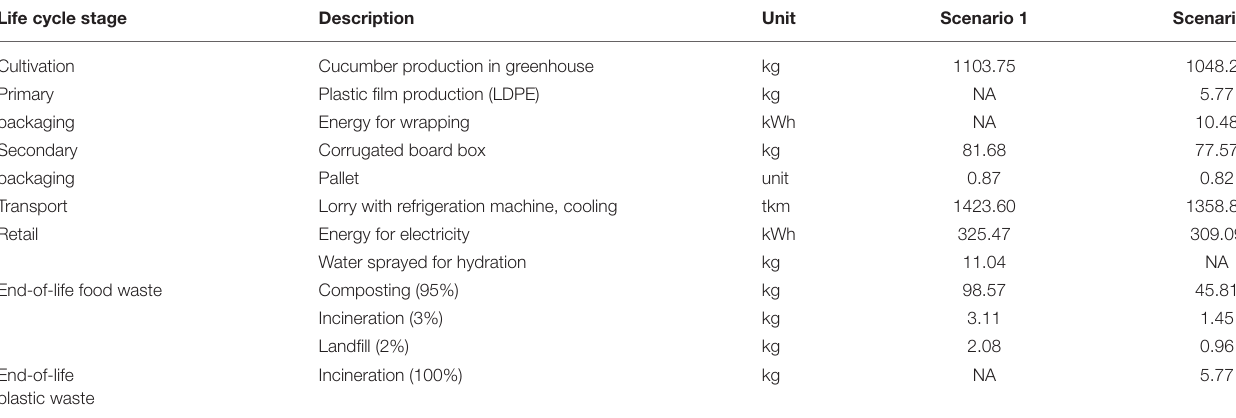
TABLE 1 | Life cycle inventory of the supply chain of cucumbers according to the scenarios presented in this